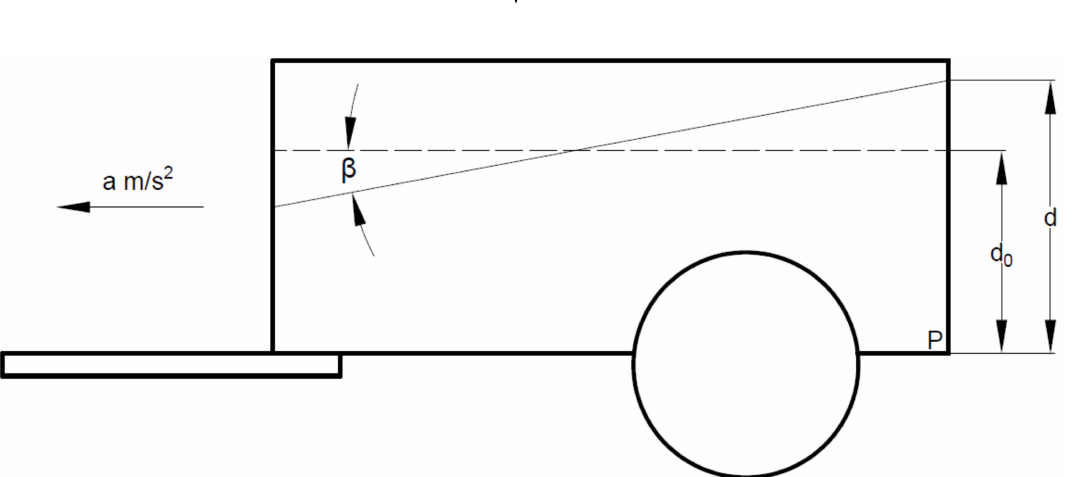
Figure 9. Vessel with an acceleration a m/s 2 towards the